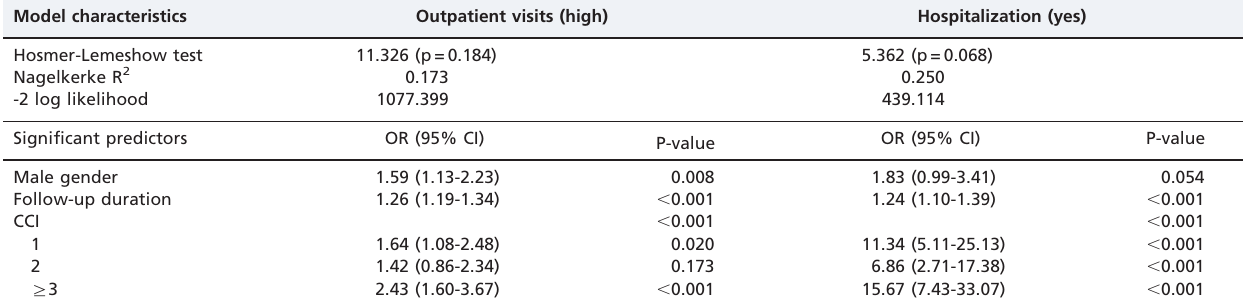
Table 3 - Significant predictors of utilization associated with ankylosing spondylitis, by multivariate analyses*. Model